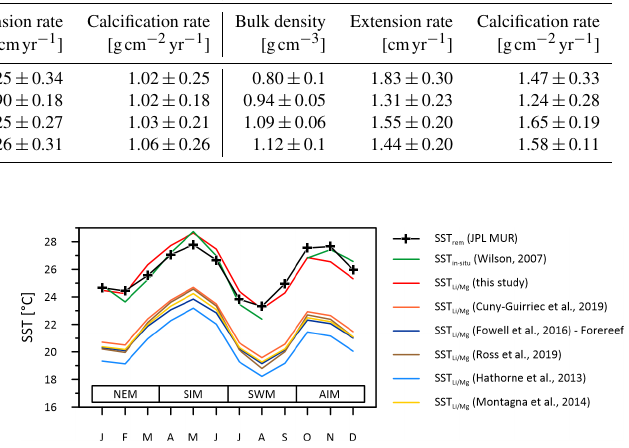
Figure 6. Multi-year monthly means of (a) calcification rate, (b) extension rate and (c) skeletal bulk density and associated Li / Mg and SSTs of three corals from Masirah Island (blue, orange, yellow). The coloured shaded polygons combine monthly data that belong to the same season. Seasonal abbreviations: NEM (northeast monsoon), SIM (spring intermonsoon), SWM (southwest monsoon), AIM (autumn intermonsoon). Table 3. Mean seasonal skeletal bulk density, linear extension rate and calcification rate ( ± 1 σ ) of three corals from Masirah Island. Un- certainty (1 σ ) represents variability between equal seasons of consecutive years. Seasonal abbreviations: NEM (northeast monsoon), SIM (spring intermonsoon), SWM (southwest monsoon), AIM (autumn intermonsoon). 5.10 5.13 5.21